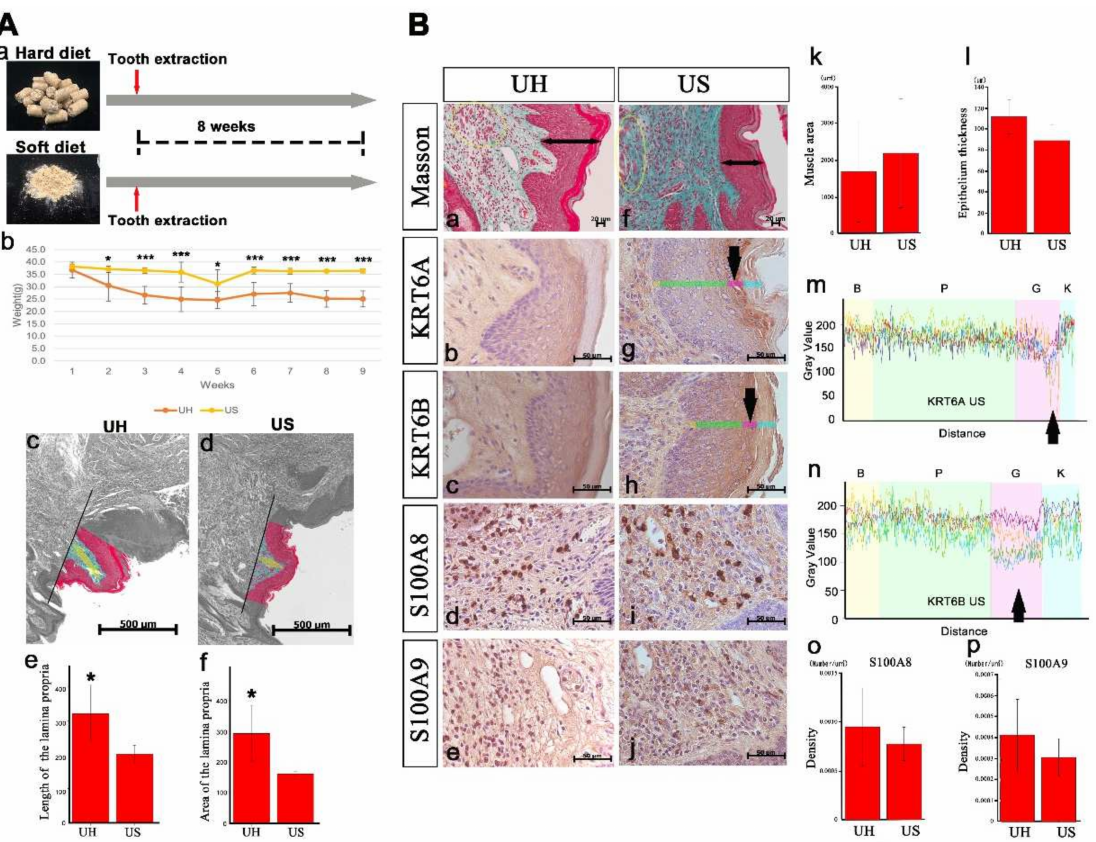
Figure 6. Soft-diet feeding affects lip morphology: ( A ) Body weight was significantly higher in the soft-diet feeding (US) group than in the hard-diet feeding (UH) group (Panel b; * p < 0.05, *** p < 0.001). Because the thickness and area of the lamina propria were smaller in US mice than in UH mice (Panels c and d) (Panels e and f; * p < 0.05), lip protrusion into the oral cavity was less severe in US mice. ( B ) The thickness of the epithelium and area of the muscle did not differ between the groups (Panels a, f, k, and l). The fluorescence intensity of KRT6A/6B in the granular layer did not differ between UH and US mice (Panels m and n). The density of S100A8/A9 was not different between the groups (Panels d, e, i, j, o, and